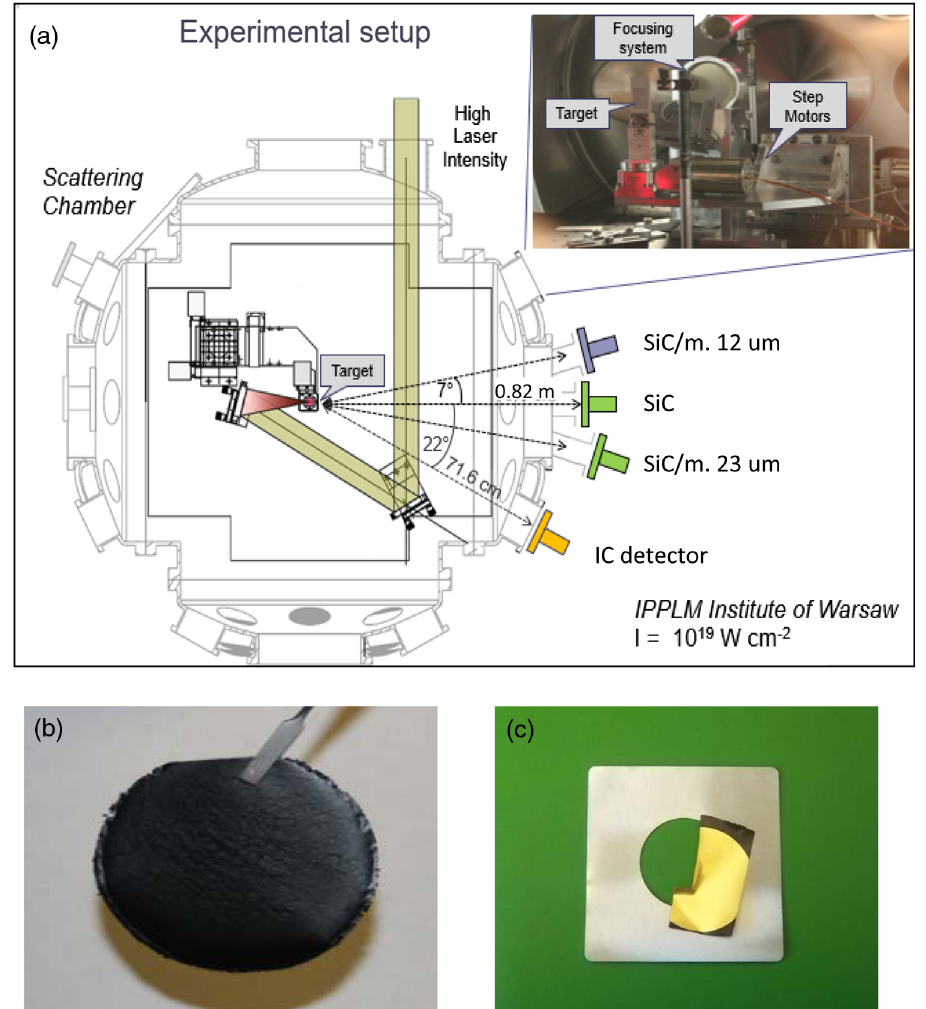
FIG. 1. Scheme and photo (inset) of the experimental setup (a) graphene oxide foil (b) and GO foil covered by 200 nmAu film